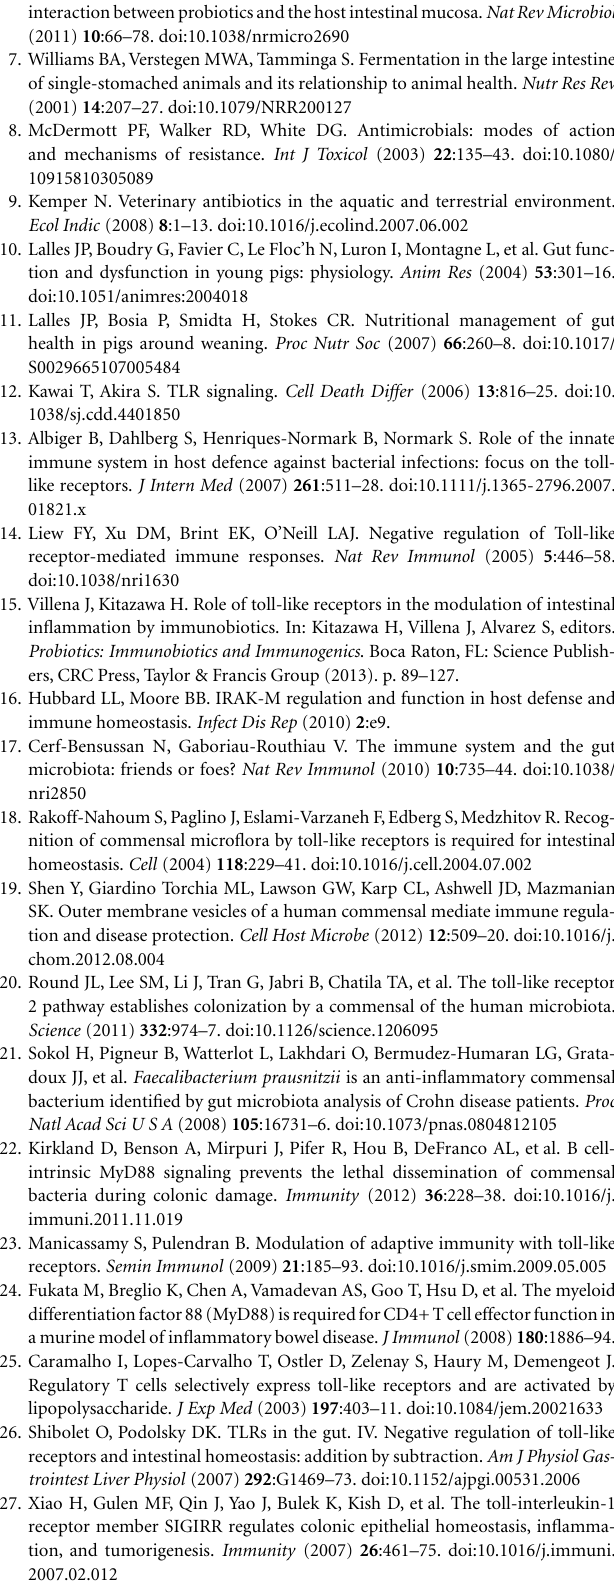
to be used as a pig probiotic feed. In addition, accumulation of empirical data in pigs may increase the probiotic use in human because the pigs are also expected for development as human